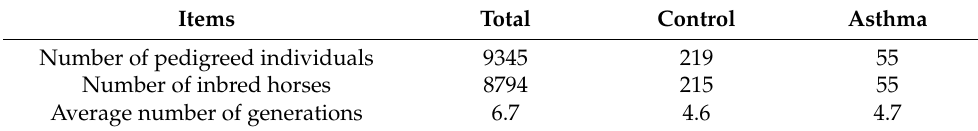
Table 2. Pedigree structure and completeness of the population studied. Items Total Control Asthma Number of pedigreed individuals 9345 219 55 Number of inbred